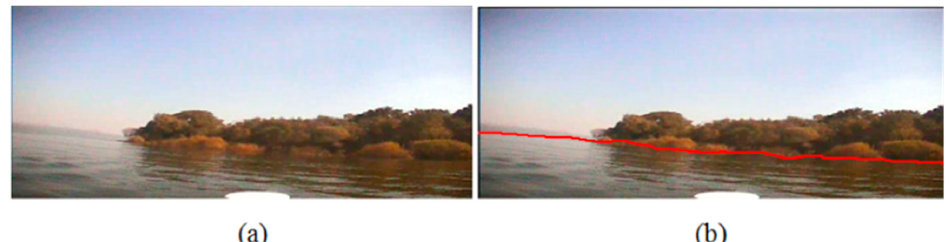
Figure 19. Waterline detection of a close bank with serious shade. ( a ) The image before our detection; ( b ) The image after our detection.